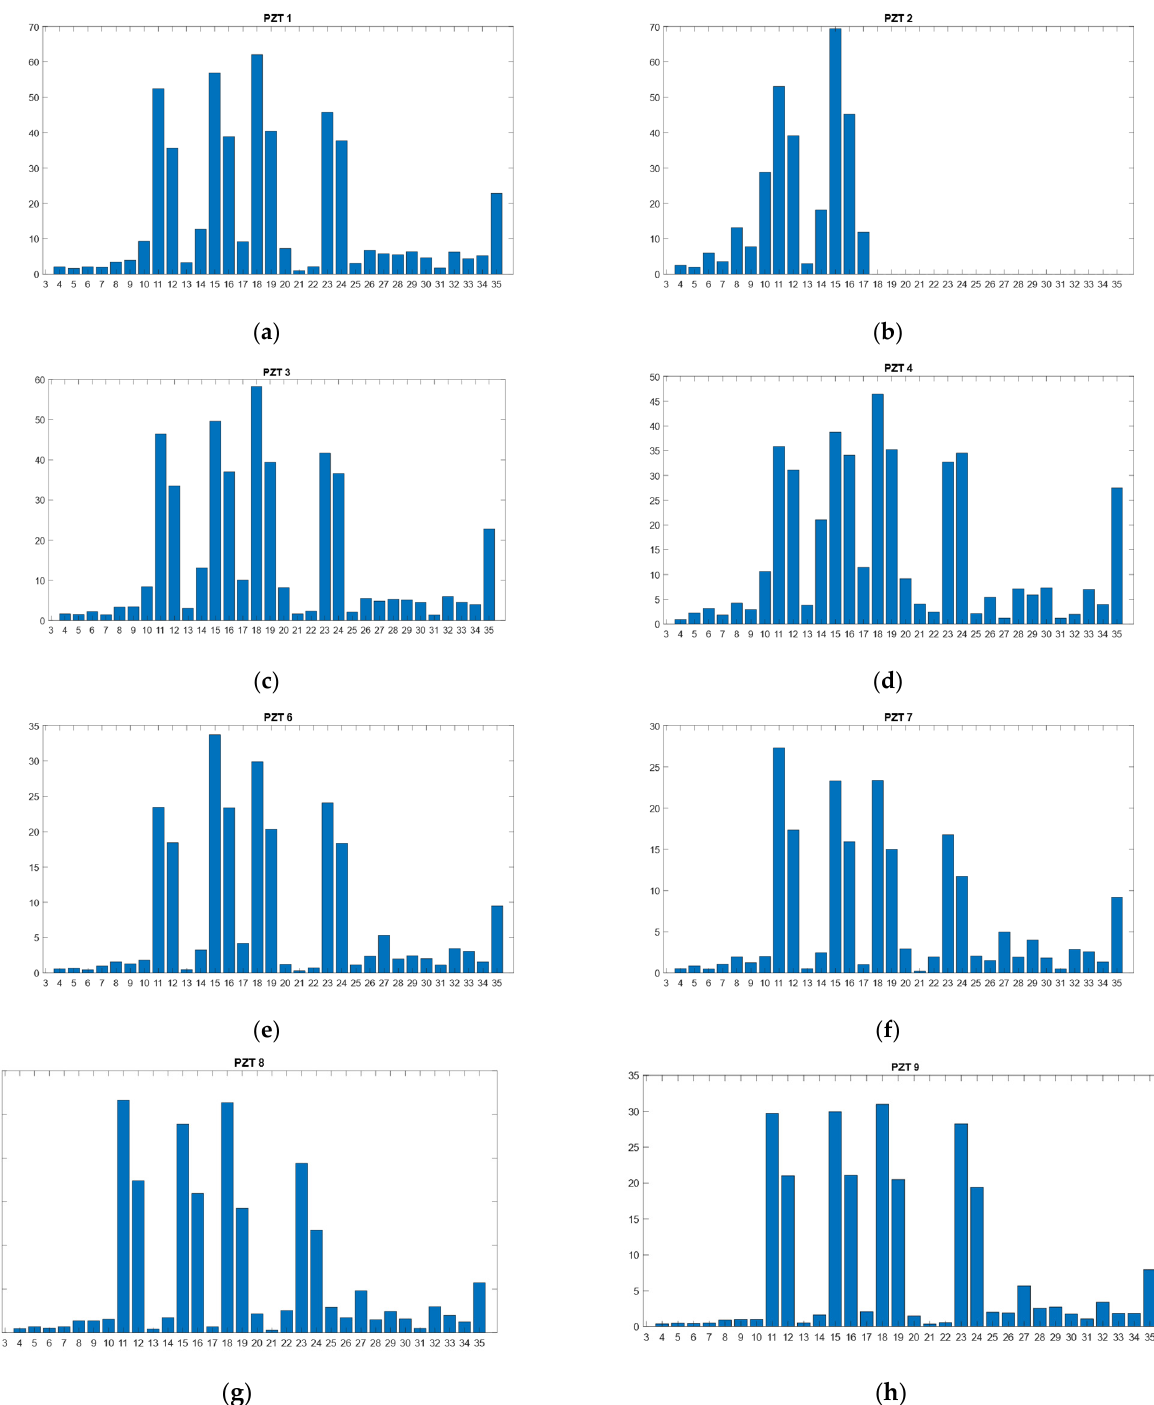
Figure 6. RMSD values for all PZT sensors. ( a ) Sensor PZT1, ( b ) Sensor PZT2, ( c ) Sensor PZT3, ( d ) Sensor PZT4, ( e ) Sensor PZT6, ( f ) Sensor PZT7, ( g ) Sensor PZT8, ( h ) Sensor PZT9.